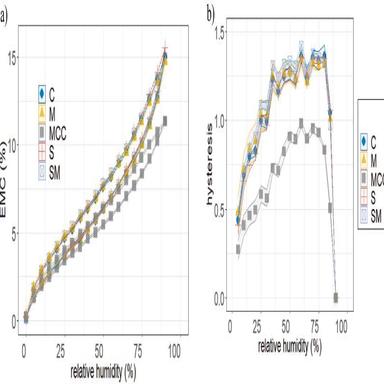
Sorption analysis: a) isotherm of differently treated cellulose and microcrystalline cellulose (MCC) as reference. The lower curve from the same material describes the adsorption, while the upper curve refers to the desorption.; b) Hysteresis of differently treated cellulose and microcrystalline cellulose (MCC) as reference.